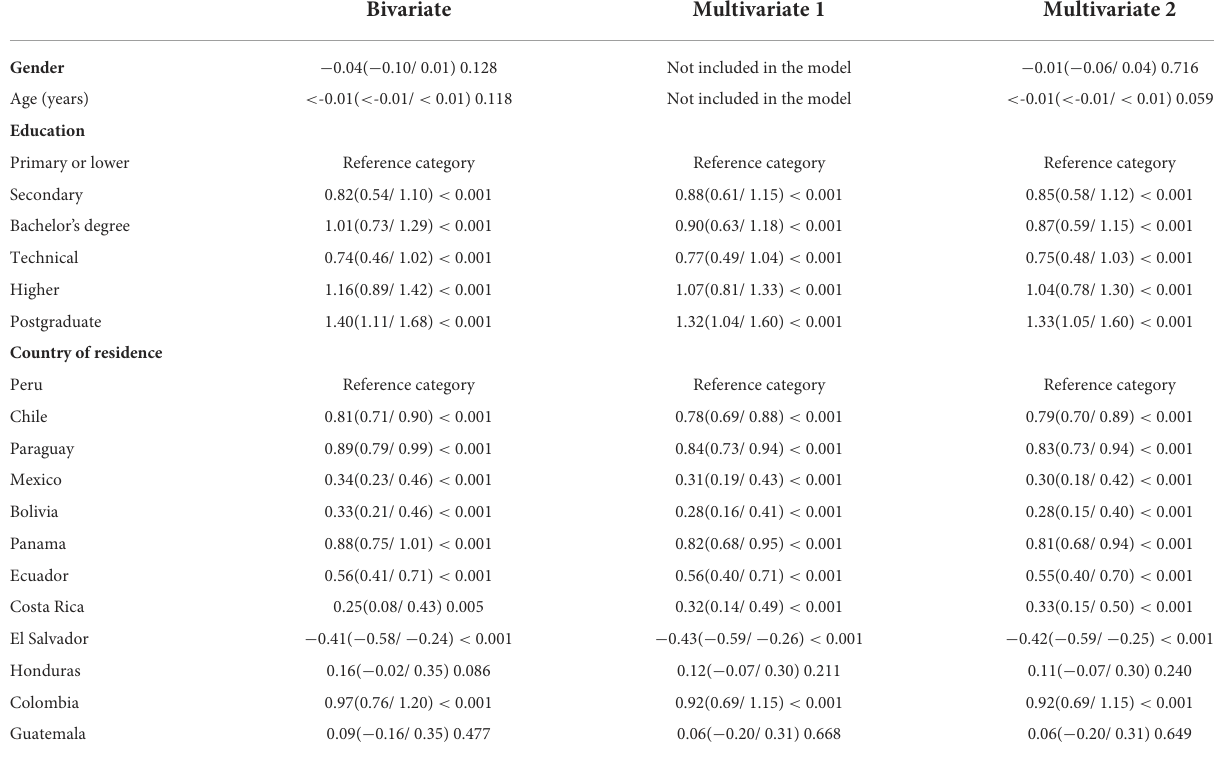
TABLE 3 Bivariate and multivariate models of the basic socio-educational factors associated with the score of basic knowledge of COVID-19 in 12 countries in Latin America. Variables Models (knowledge score as a dependent variable) Bivariate Multivariate